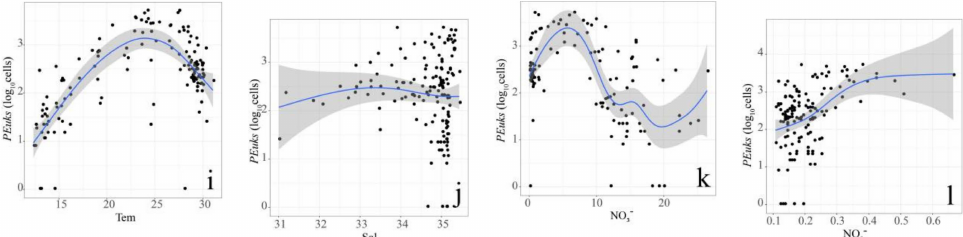
Figure 9. Results of GAMs describing the abundance of pico variability with temperature, salinity, nitrate, and nitrite in the EIO. ( a ) the abundance of Syn with temperature. ( b ) the abundance of Syn with salinity. ( c ) the abundance of Syn with NO 3 − . ( d ) the abundance of Syn with NO 2 − . ( e ) the abundance of Pro with temperature. ( f ) the abundance of Pro with salinity. ( g ) the abundance of Pro with NO 3 − . ( h ) the abundance of Pro with NO 2 − . ( i ) the abundance of PEuks with temperature. ( j ) the abundance of PEuks with salinity. ( k ) the abundance of PEuks with NO 3 − . ( l ) the abundance of PEuks with NO 2 − . Solid blue lines represent smoothed mean relationships from GAMs, and shaded areas are 95% confidence intervals (R 2 = 0.706). Prochlorococcus ( Pro ), Synechococcus ( Syn ), and Picoeukaryotes ( PEuks ), Nitrate (NO 3 − ), Nitrite (NO 2 −